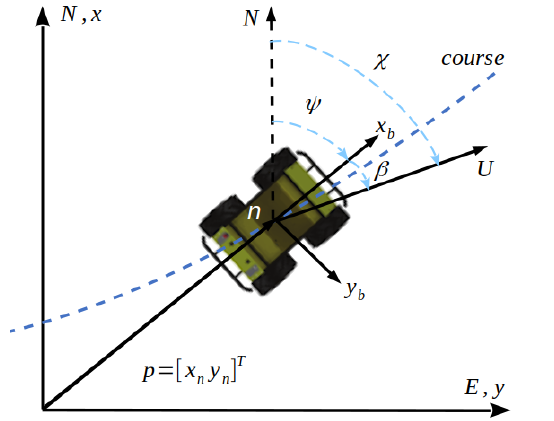
Figure 9. Three-DOF maneuvering coordinate system